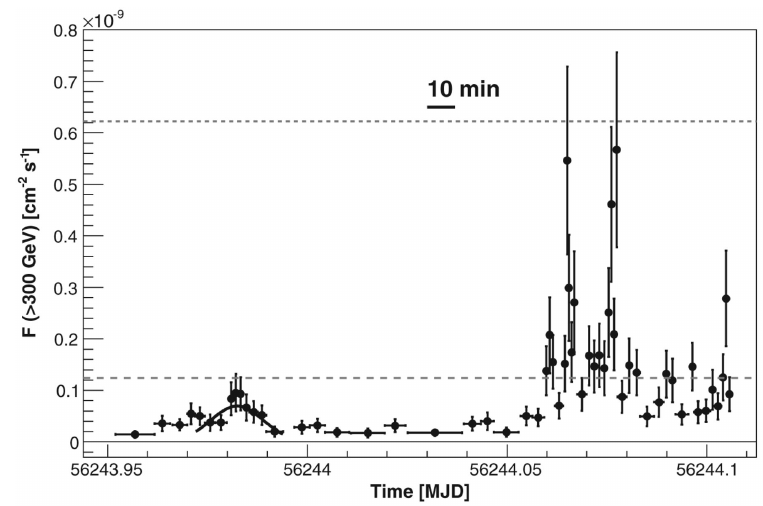
Figure 4. VHE light curve of IC 310 above 300 GeV as observed by MAGIC during 12–13 November 2012. Rapid VHE variability on doubling timescale well below 10 min is apparent in the light curve. The two gray lines indicate flux levels of 1 and 5 Crab units, respectively. From Ref.